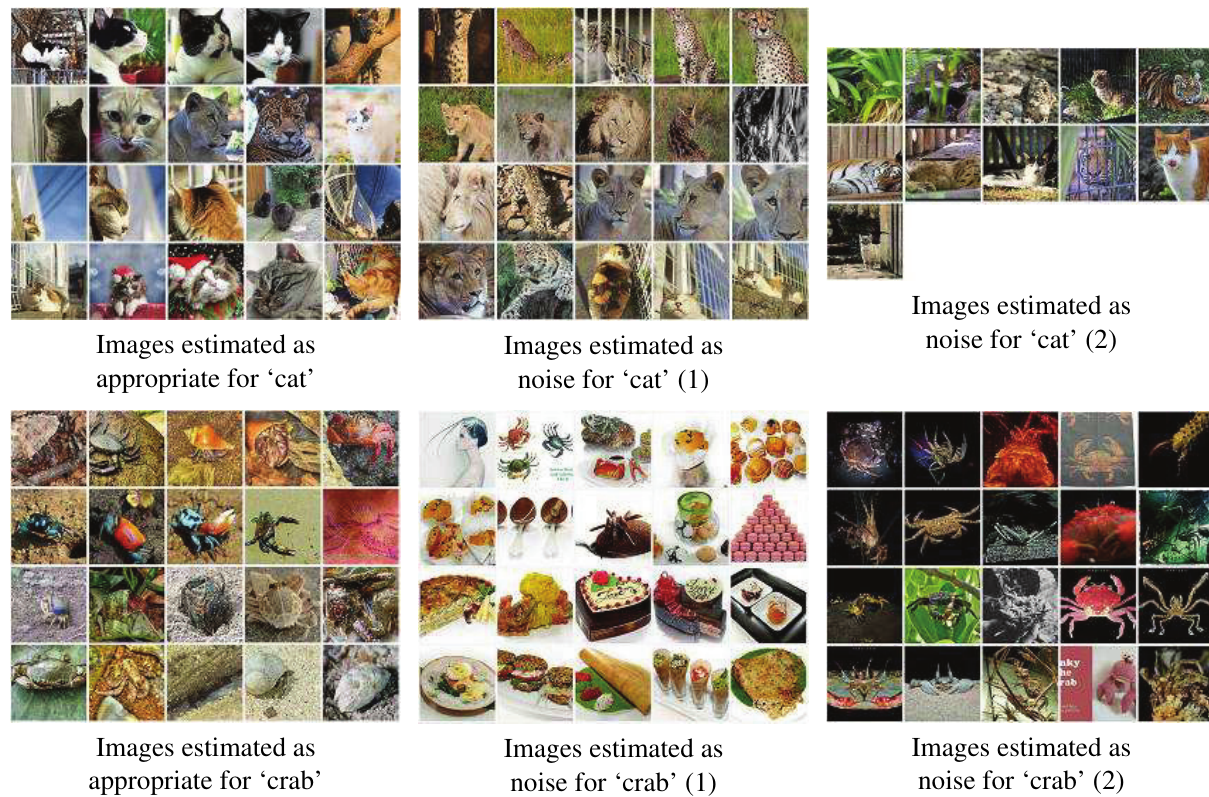
Figure 4: Examples of images estimated as appropriate and noise for ‘cat’ and